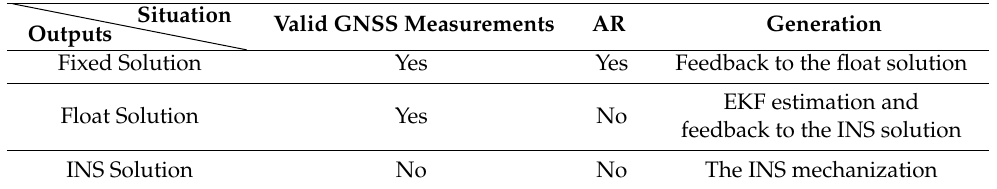
Table 3. The outputs cases.